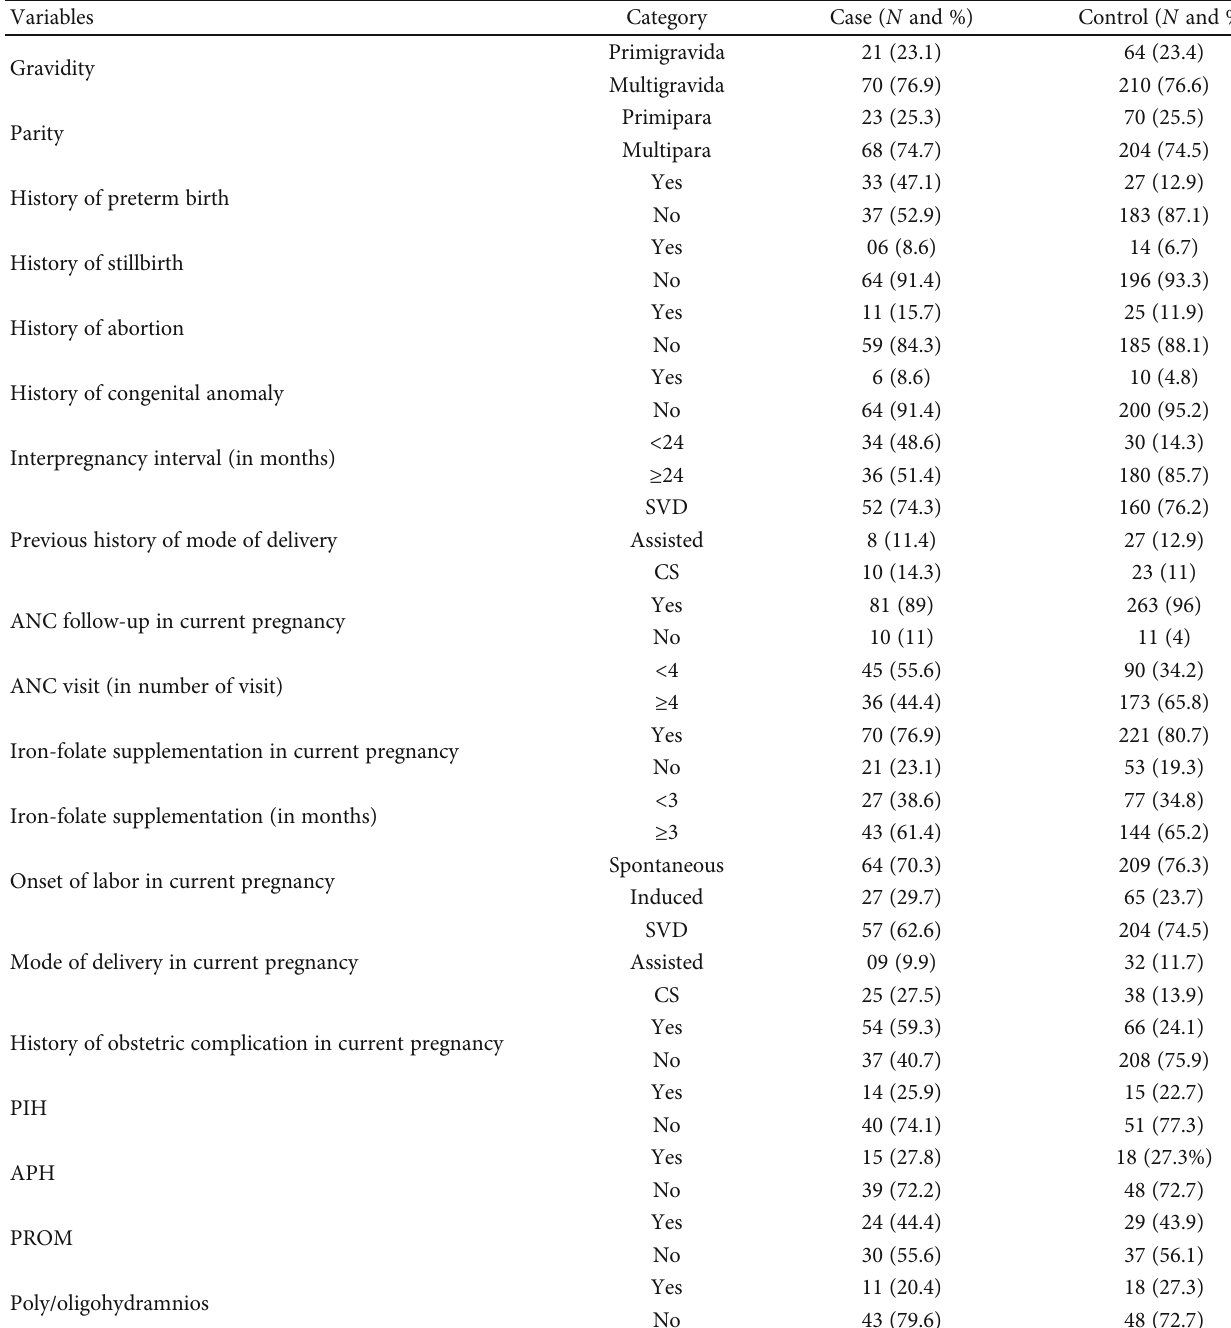
Table 2: Obstetric and gynecologic characteristics of mothers who gave birth in Silte Zone Public Hospitals, Southern Ethiopia (2019/20).